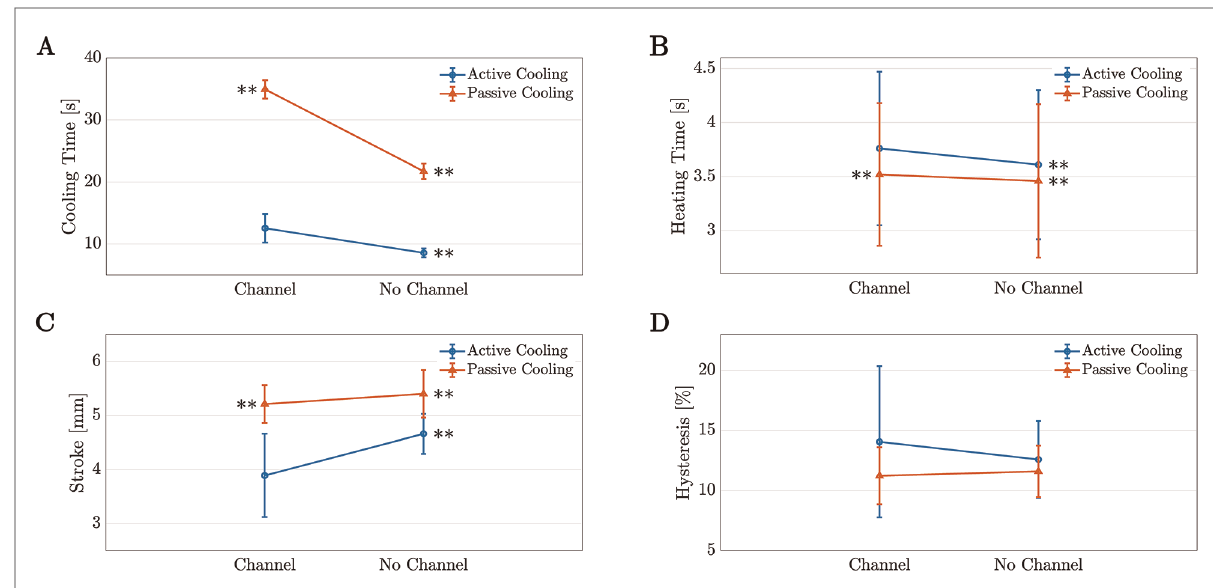
FIGURE 9 The means and standard deviations for the data from Phase II plotted for ( A ) cooling time, ( B ) heating time, ( C ) stroke, ( D ) and maximum hysteresis as a percent of stroke. The number adjacent to the point marks which case it is and if there is a statistically signi fi cant difference with Case 1 (channel, Active Cooling), it is marked by (cid:4)(cid:4) for p , 0 :